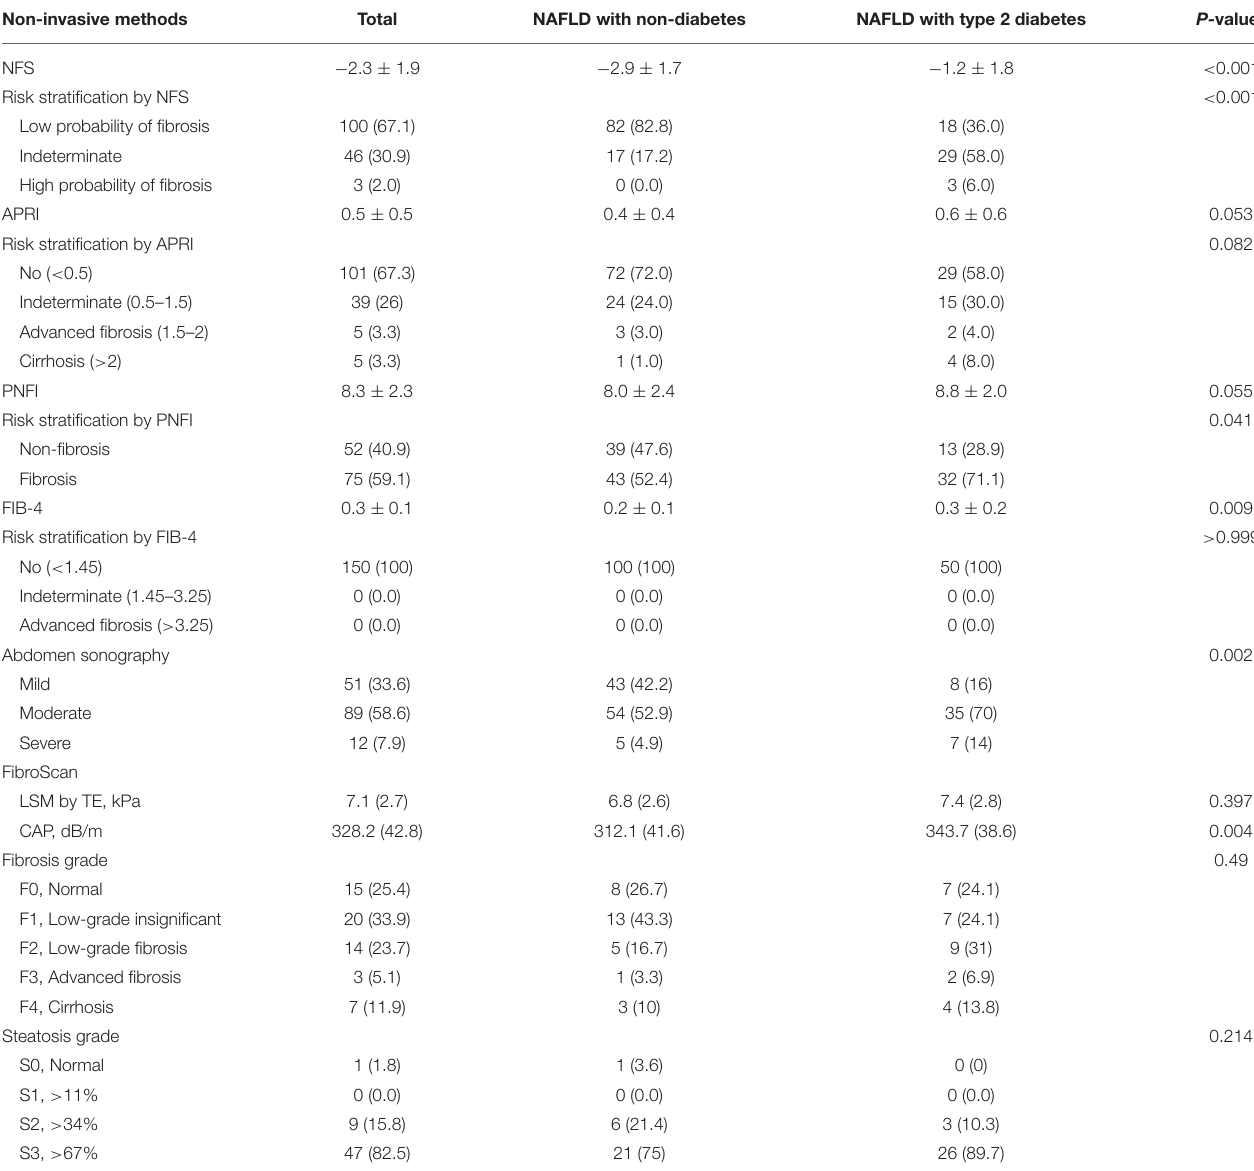
TABLE 2 | Non-invasive fibrosis markers and non-invasive imaging assessment in children/adolescents with NAFLD. Non-invasive methods Total NAFLD with non-diabetes NAFLD with type 2 diabetes P-